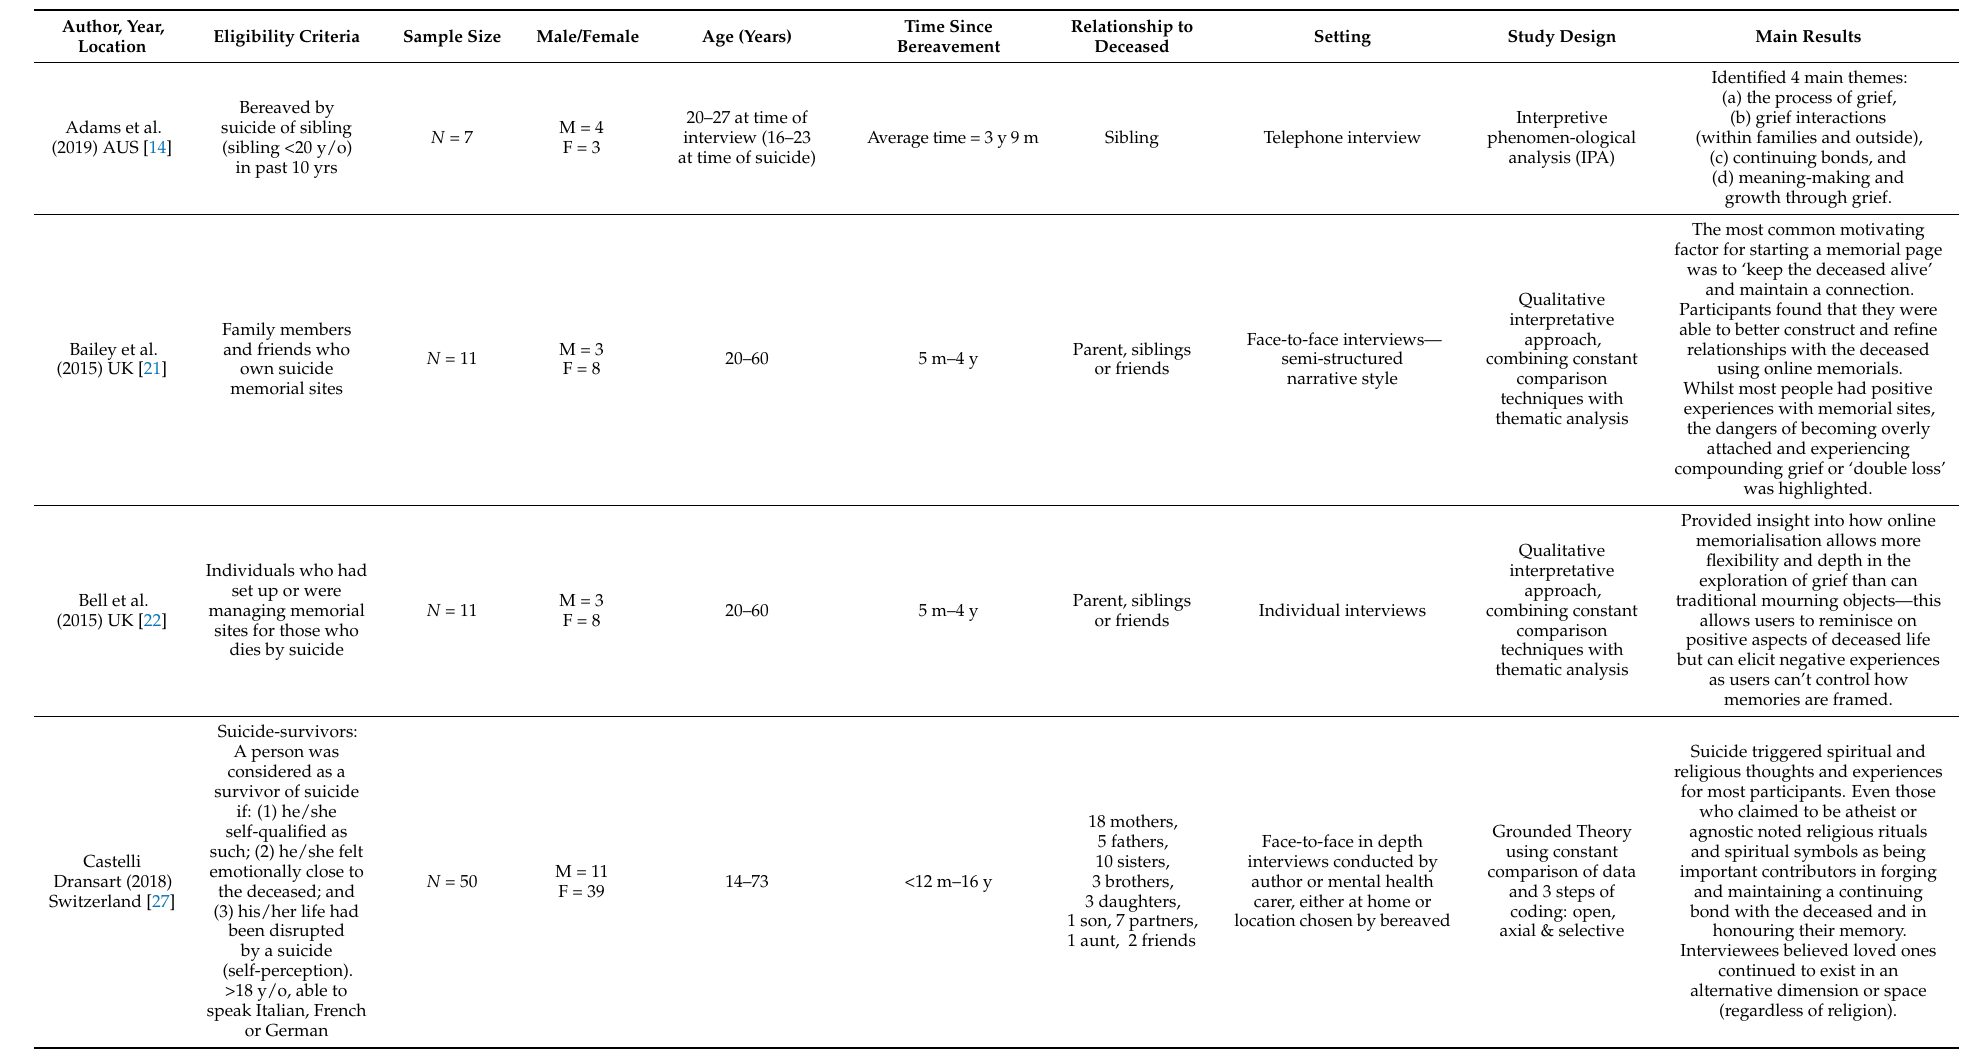
Table 2. Summary of qualitative